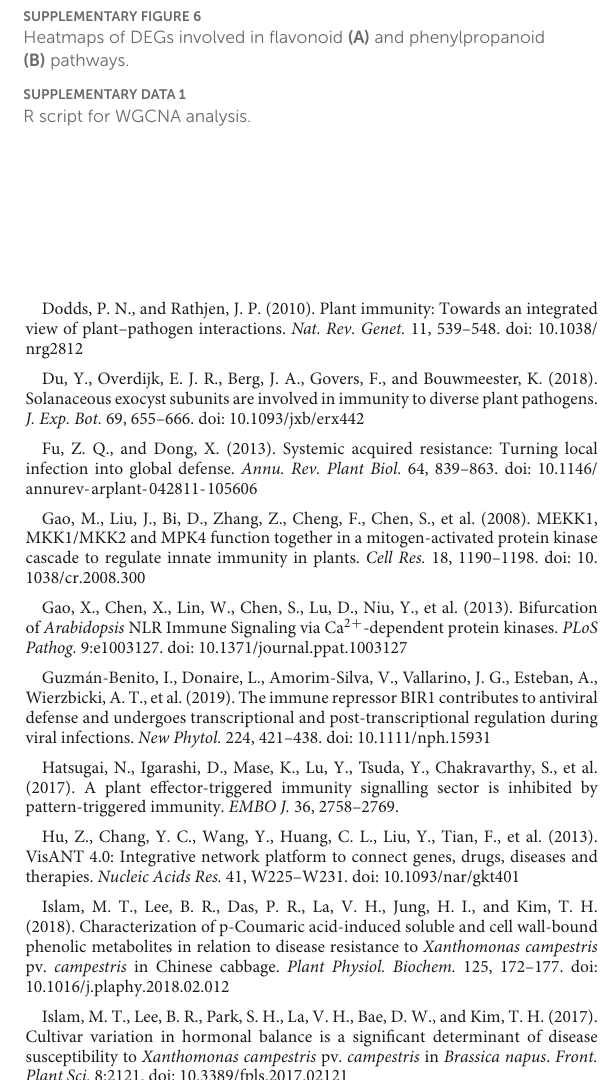
SUPPLEMENTARYFIGURE6 Heatmaps of DEGs involved in flavonoid (A) and phenylpropanoid (B) pathways. SUPPLEMENTARYDATA1 R script for WGCNA